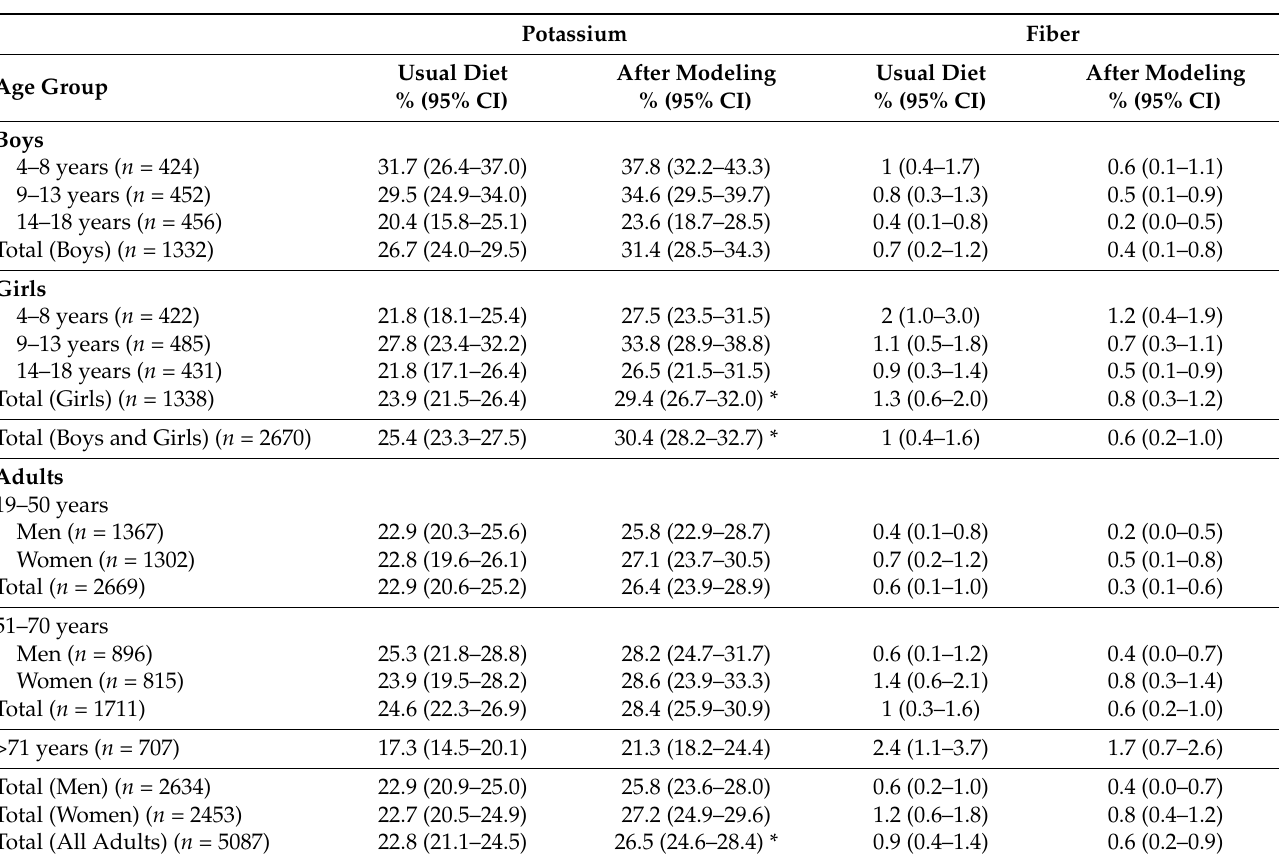
Table 4. Percentage of individuals with nutrient intakes above the AL a at usual (current) and modeled intakes (addition of 1 ounce of